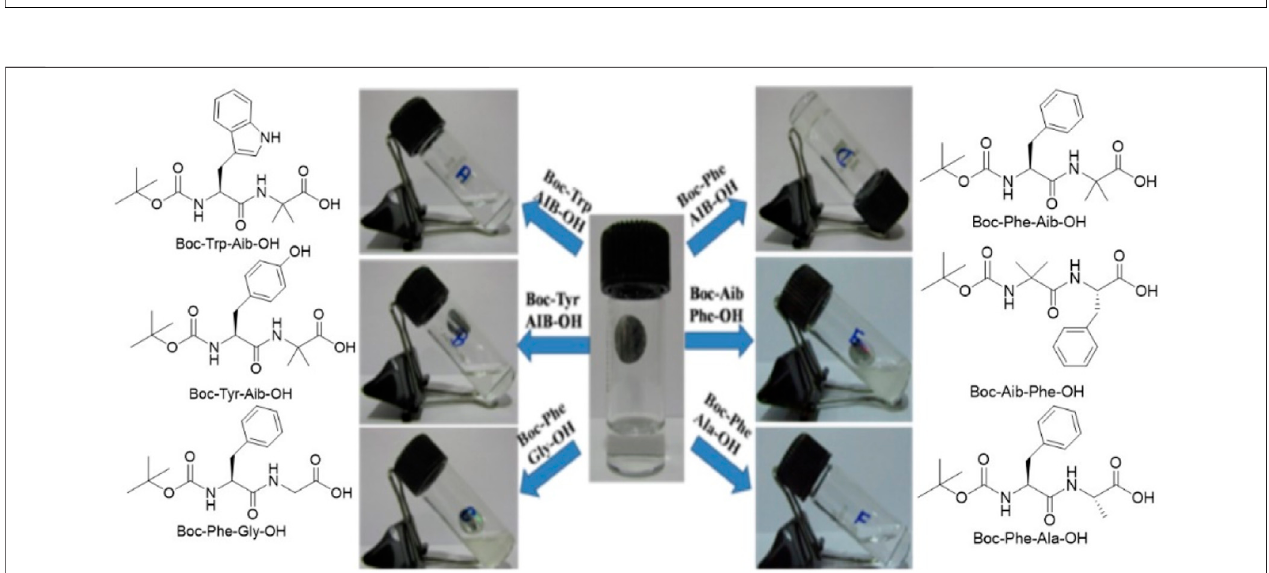
FIGURE 7 | The structures of dipeptide Boc-Phe-Aib analogs and their gelation studies (Nandi et al., 2018).